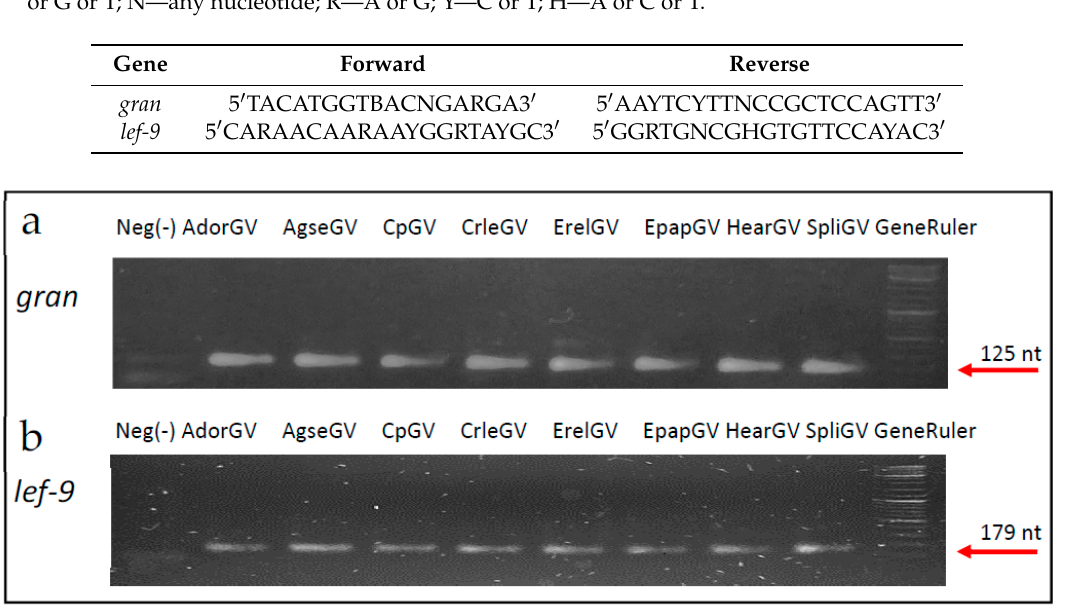
Table 2. Primers used in PCR reactions to amplify short fragments of gran and core gene— lef-9. B—C or G or T; N—any nucleotide; R—A or G; Y—C or T; H—A or C or T.